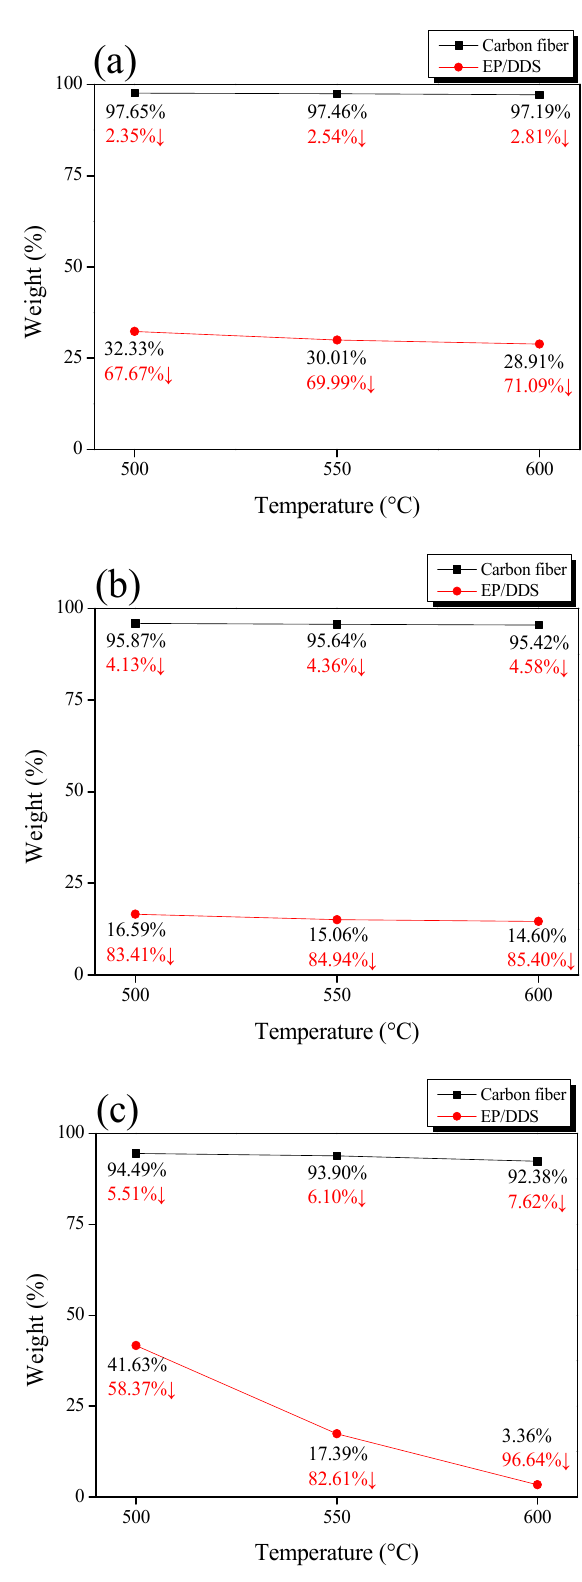
Figure 5. Weight loss of as-received carbon fiber and epoxy resin pyrolysis under gas atmosphere: ( a ) N 2 , ( b ) steam, and ( c ) air.